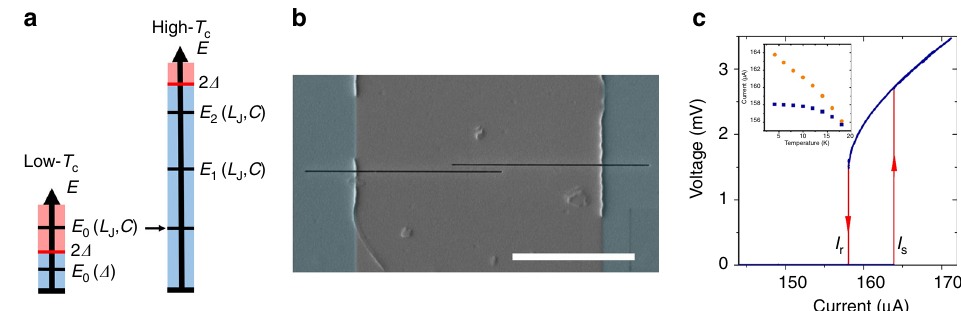
Fig. 1 YBCO nanowire with phase-slip dynamics. a Energy diagrams for low- T c and high- T c nanowires. Energies below and above 2 Δ are shown in blue and red, respectively. b Scanning electron micrograph of an YBCO nanowire shaped by two FIB cuts across a microbridge. The YBCO fi lm, STO substrate and FIB cuts are shown in gray, blue, and black, respectively. The scale bar corresponds to 5 μ m. c IV curve of a 55-nm-wide YBCO nanowire at 4.2 K. Inset: temperature dependences of the average switching I s (orange circles) and retrapping I r (blue squares) currents. Source data are provided as a Source Data